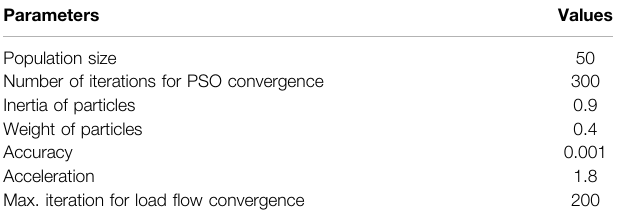
TABLE 7 | Control parameters of the PSO algorithm. Parameters